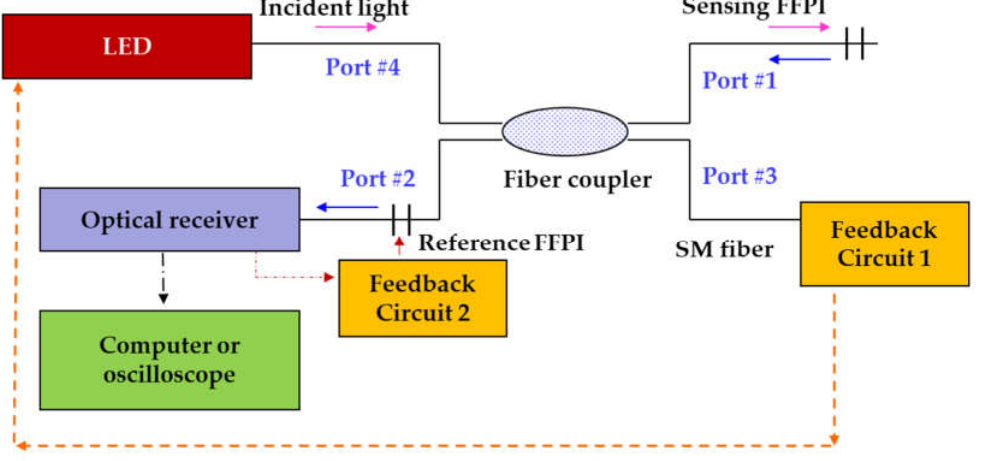
Figure 2. Schematic functional block diagram of a dual FFPI [30].